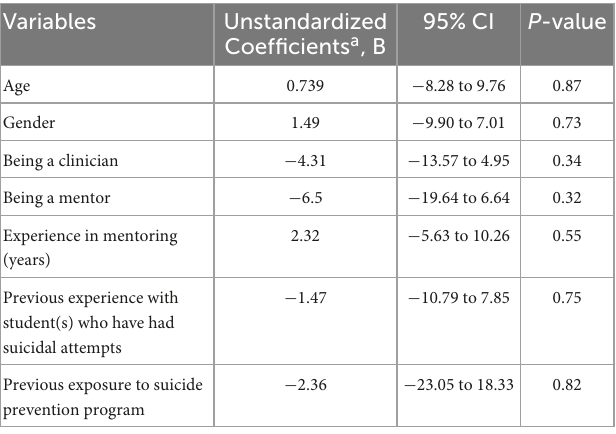
TABLE 3 Multiple linear regressions for potential